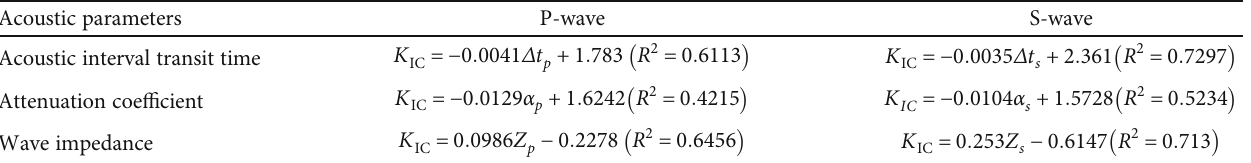
Note: K IC represents the mode I fracture toughness, simpli fi ed fracture toughness; Δ t p represents the P-wave acoustic interval transit time; Δ t s represents the S- wave acoustic interval transit time; α p represents the P-wave attenuation coe ffi cient; α s represents the S-wave attenuation coe ffi cient; Z p represents the P-wave impedances; Z s represents the S-wave impedances.